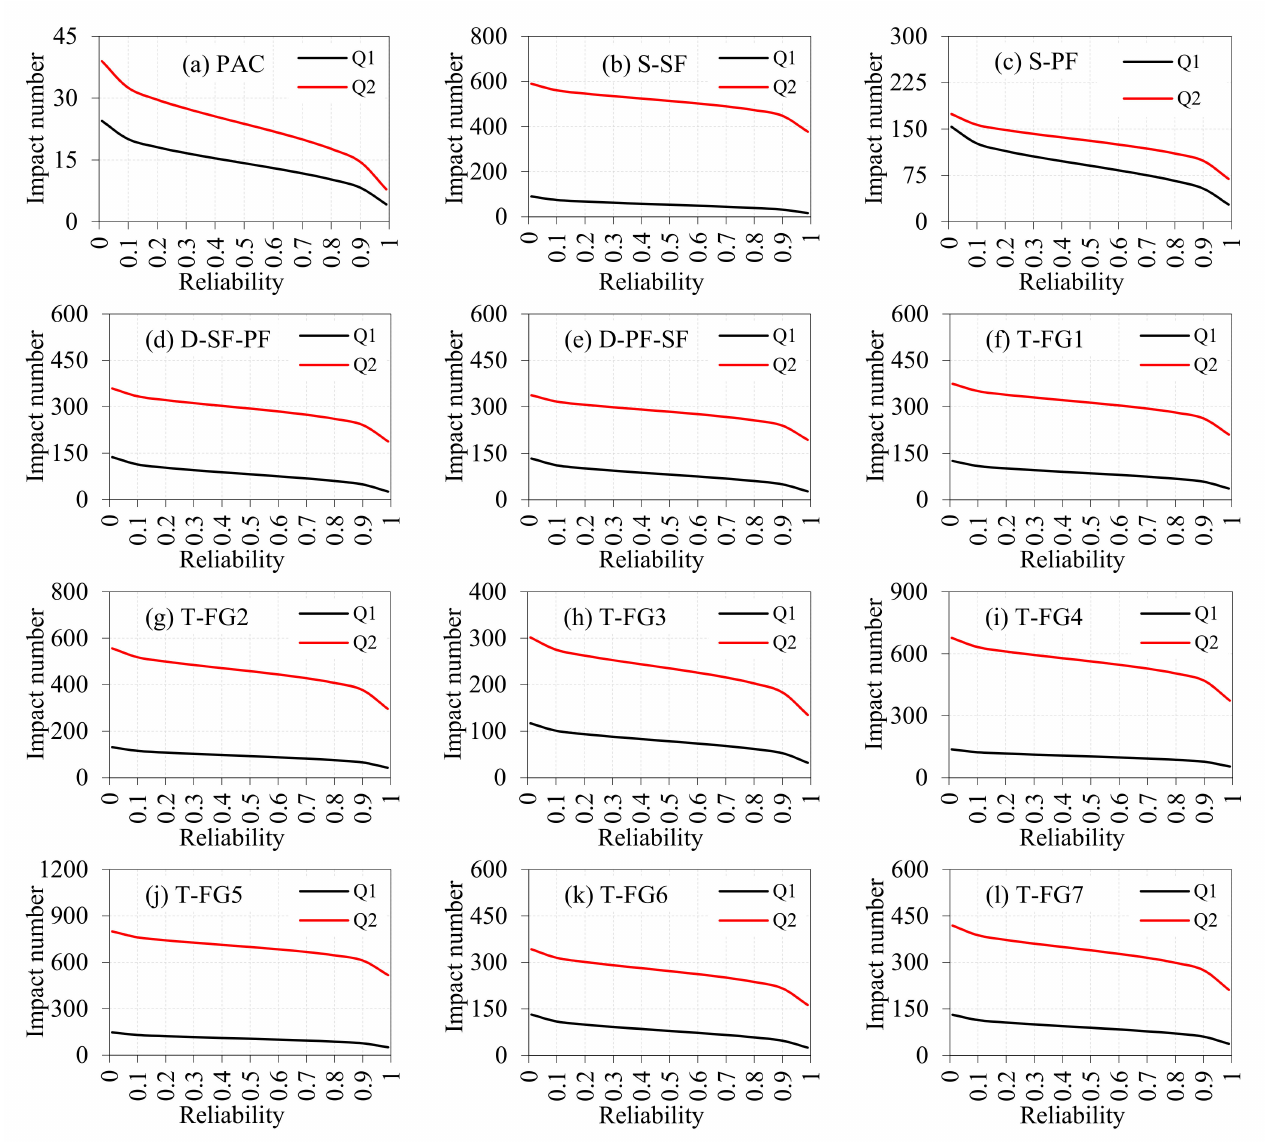
Figure 20. Q1 and Q2 in terms of reliability ( a ) PAC, ( b ) S-SF, ( c ) S-PF, ( d ) D-SF-PF, ( e ) D-PF-SF, ( f ) T-FG1, ( g ) T-FG2, ( h ) T-FG3, ( i ) T-FG4, ( j ) T-FG5, ( k ) T-FG6, ( l )